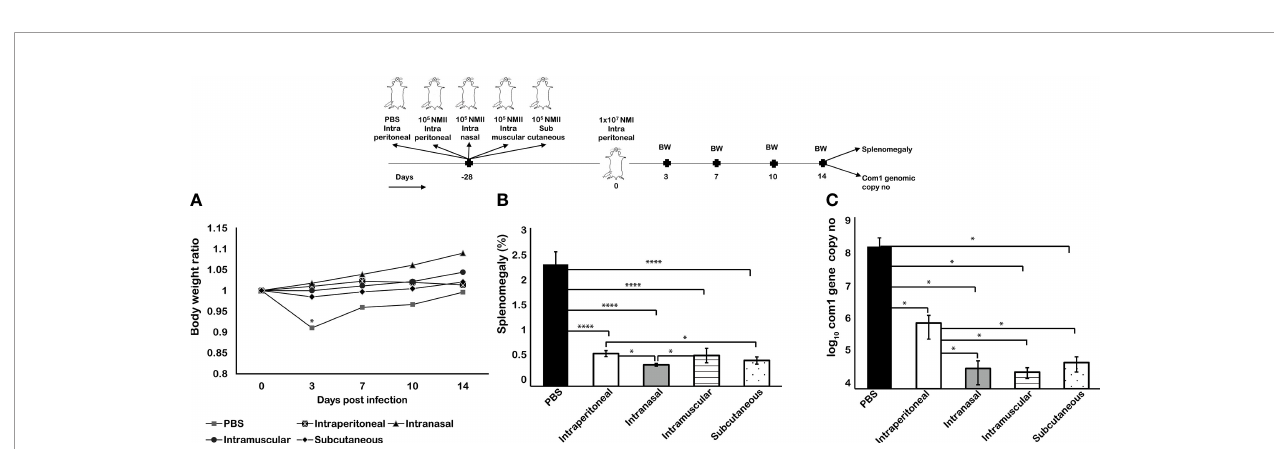
FIGURE 5 | Mouse immunization with viable NMII via different routes conferred similar protection against virulent NMI challenge. BALB/c mice were vaccinated with 10 5 GE of viable NMII via IP, IN, IM, or SQ routes and IP challenged with 1 × 10 7 GE of NMI at 28 dpv. Body weight ratio (A) , splenomegaly [ (B) , % of spleen weight/body weight], and bacterial burden (log 10 C. burnetii com1 gene copy numbers) in the spleen (C) were evaluated at 14 dpi. Each experimental group includes four mice, with error bars representing the standard deviations from the means. *p < 0.05; ****p < 0.0001, as determined by Welch t test using